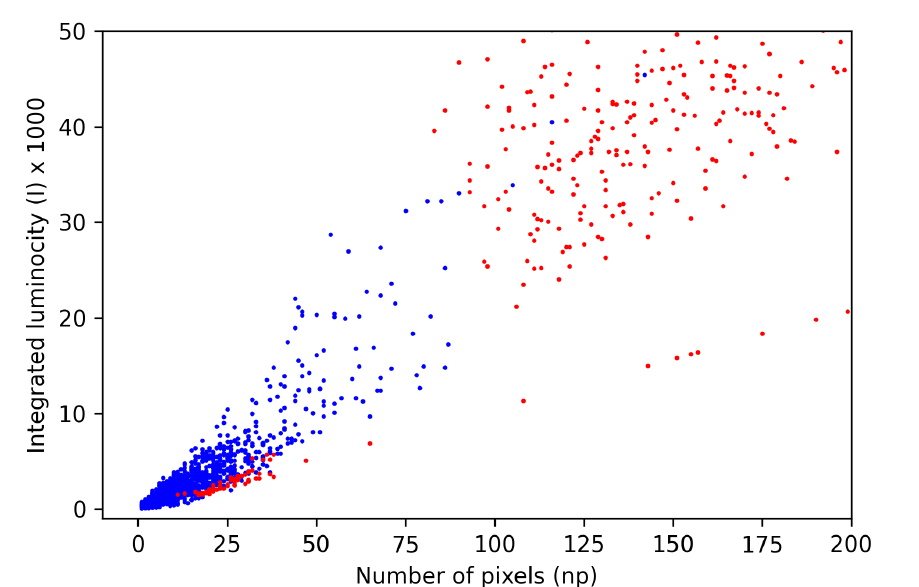
Figure 8. Structural distribution of samples belonging to each class in the feature space (partially scaled-up key area). Points assigned to signals and artefacts are marked blue and red,